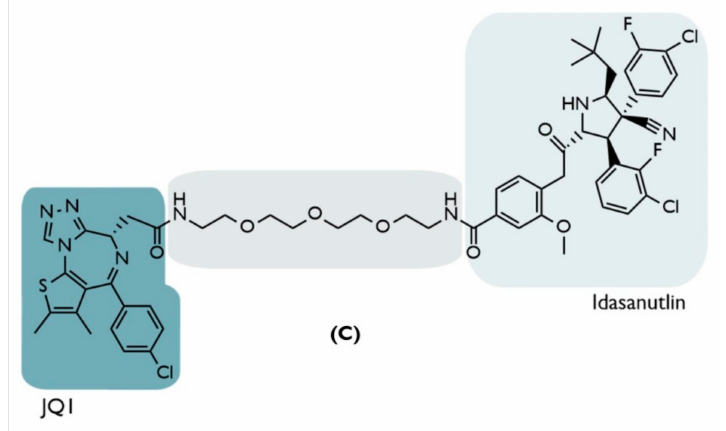
Figure 8. Chemical structure of PROTAC C. Recruiting Bromodomain Containing 4 (BRD4) via the JQ1 inhibitor, PROTAC C degrades the target, recruiting MDM2 via the inhibitor idasanutlin. Both inhibitors are linked together through a 13-atom PEG derivative